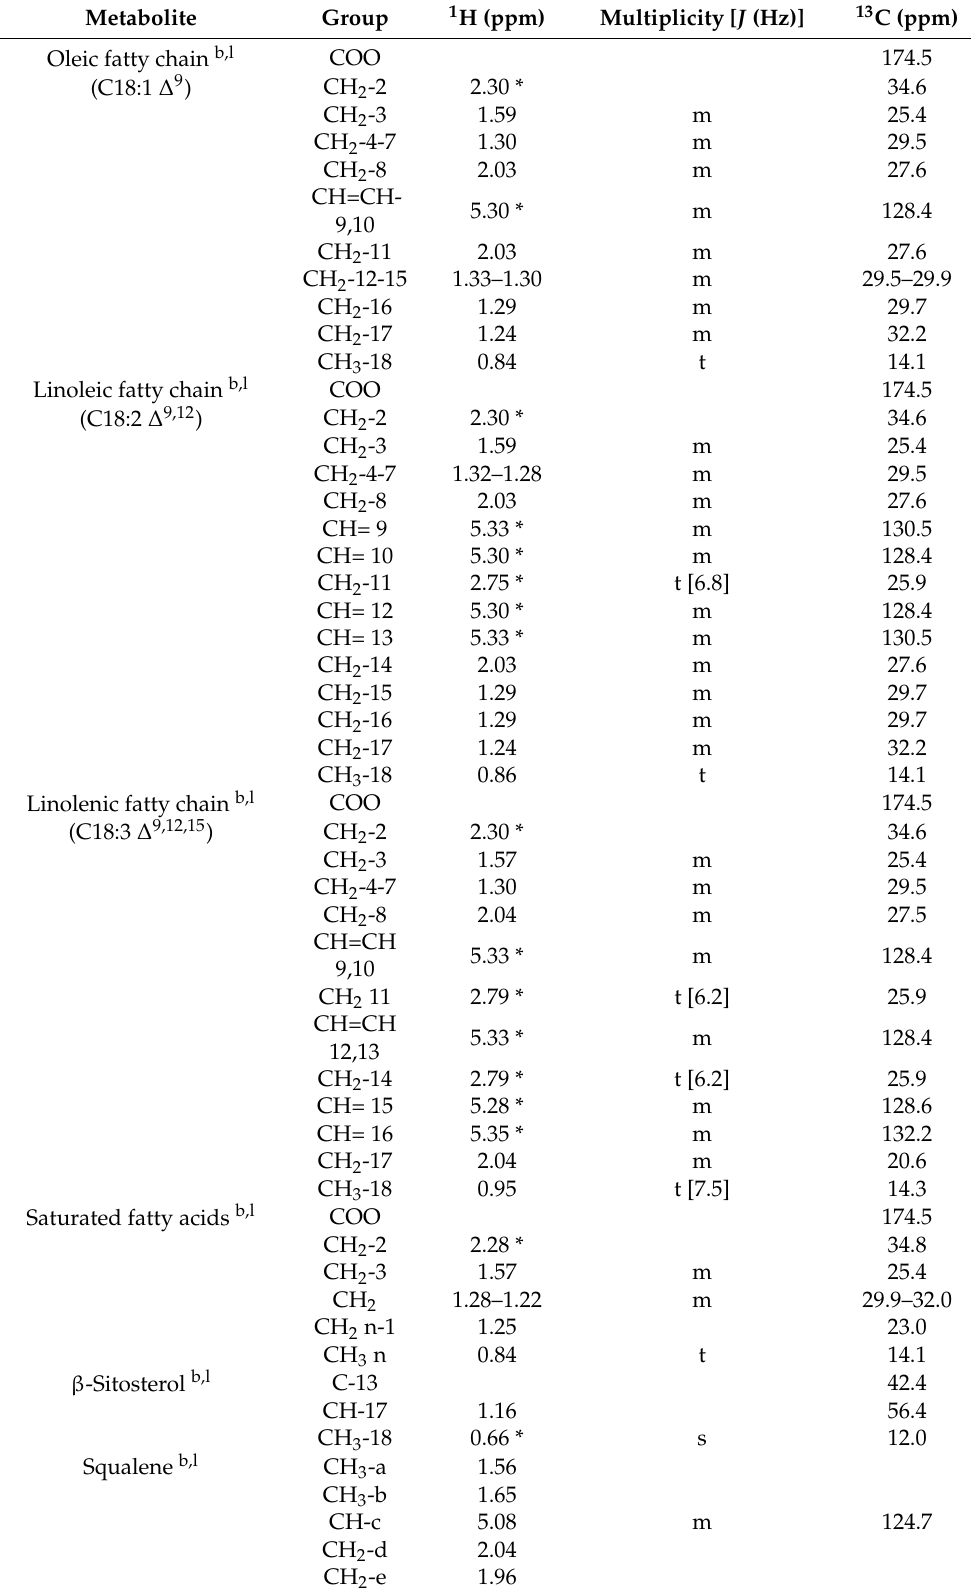
Table 2. Metabolites identified in the 600.13 MHz 1 H-NMR (Nuclear Magnetic Resonance) spectra of the Bligh-Dyer organic extracts of Goji berries dissolved in CDCl 3 /MeOD 2:1 v/v mixture. Signals selected for quantitative analysis (integration) are labeled with an asterisk